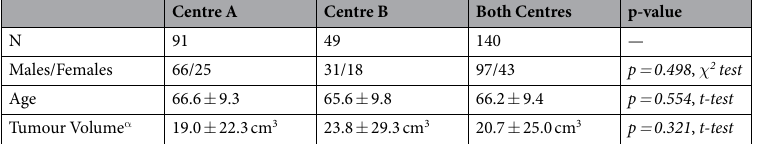
Table 1. Patient Characteristics. α according to the segmentation performed by the experienced reader. No significant difference has been found between the two centres.